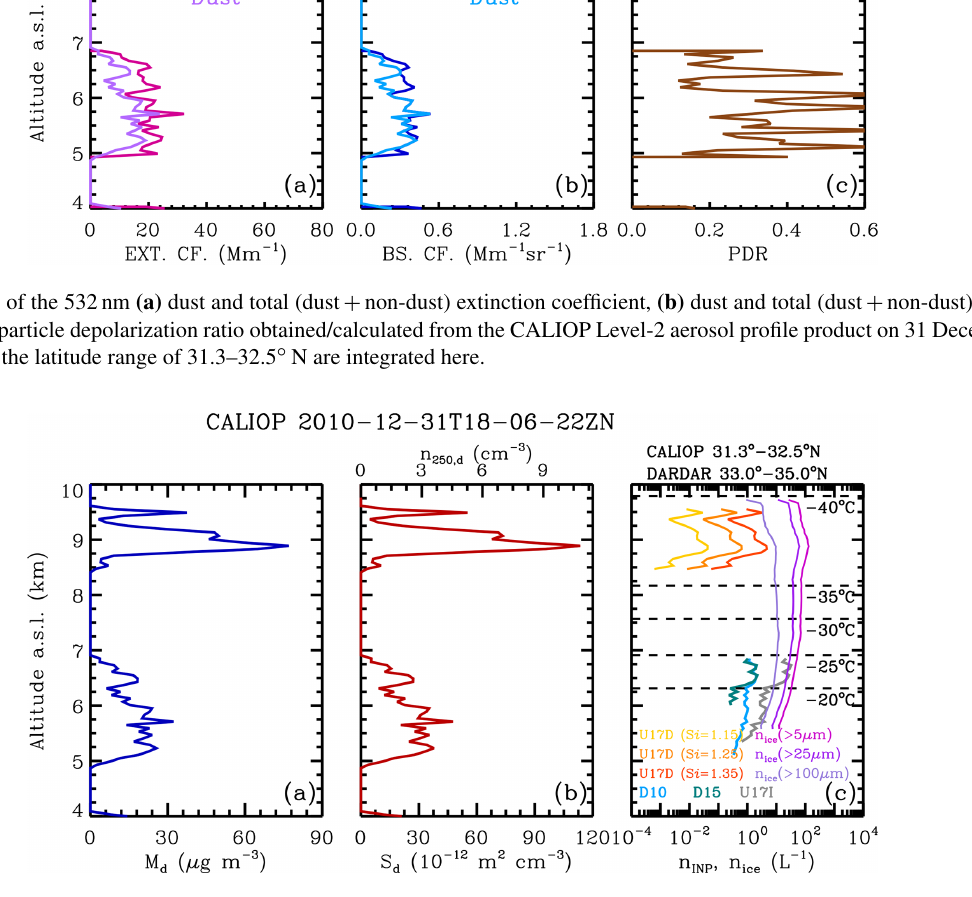
Figure 11. Profiles of the (a) dust mass concentration M d , (b) particle number concentration (with radius > 250nm) n 250 , d and surface area concentration S d , and (c) ice-nucleating particle concentration n INP (derived by the POLIPHON method using the parameterization schemes of D10, D15, U17-D, and U17-I) and ice crystal number concentration n ice (from DARDAR-Nice data product) on 31 December 2010. INP-related parameters are calculated from the dust-related optical properties given in Fig. 10 (corresponding to the CALIOP footprints between 31.3–32.5 ◦ N). For the DARDAR-Nice product, the profiles within the latitude range of 33.0–35.0 ◦ N are integrated. S i denotes the ice saturation